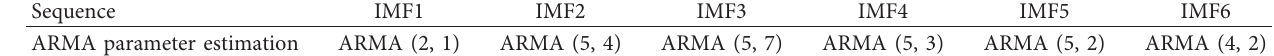
Table 1: ARMA model parameters of IMF components.